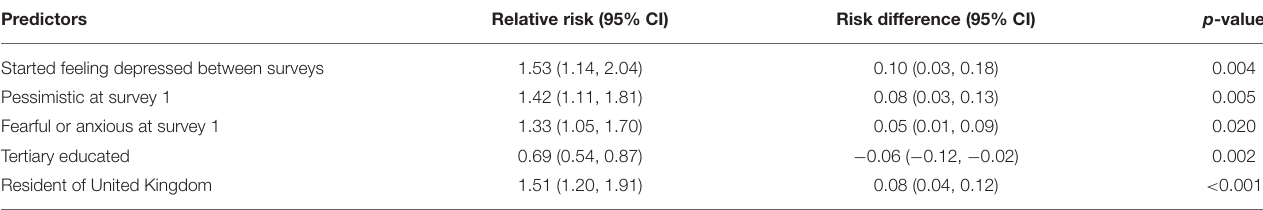
TABLE 5 | *Independent predictors of alcohol stockpiling at survey 2 in midlife women in Australia and the United Kingdom—May–July 2020 ( n = 1,222).